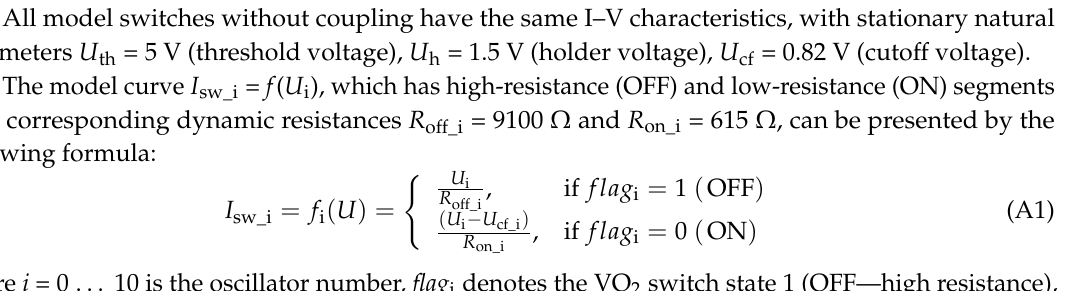
Figure A2. Typical experimental I–V characteristics of a separate switch (Experiment curve) and its model curve (Model curve).